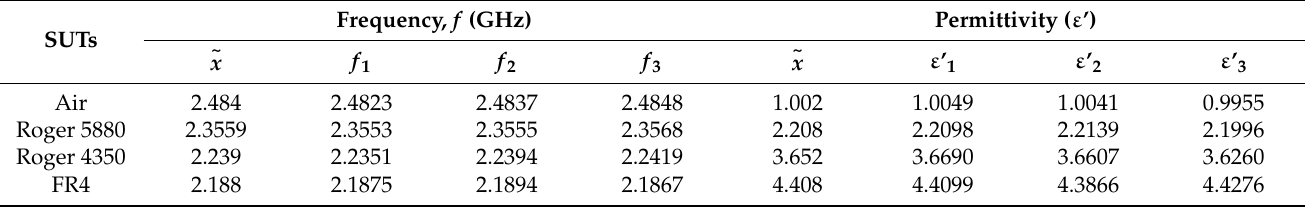
Table 8. Repetitiveness data in measuring the dielectric value of the